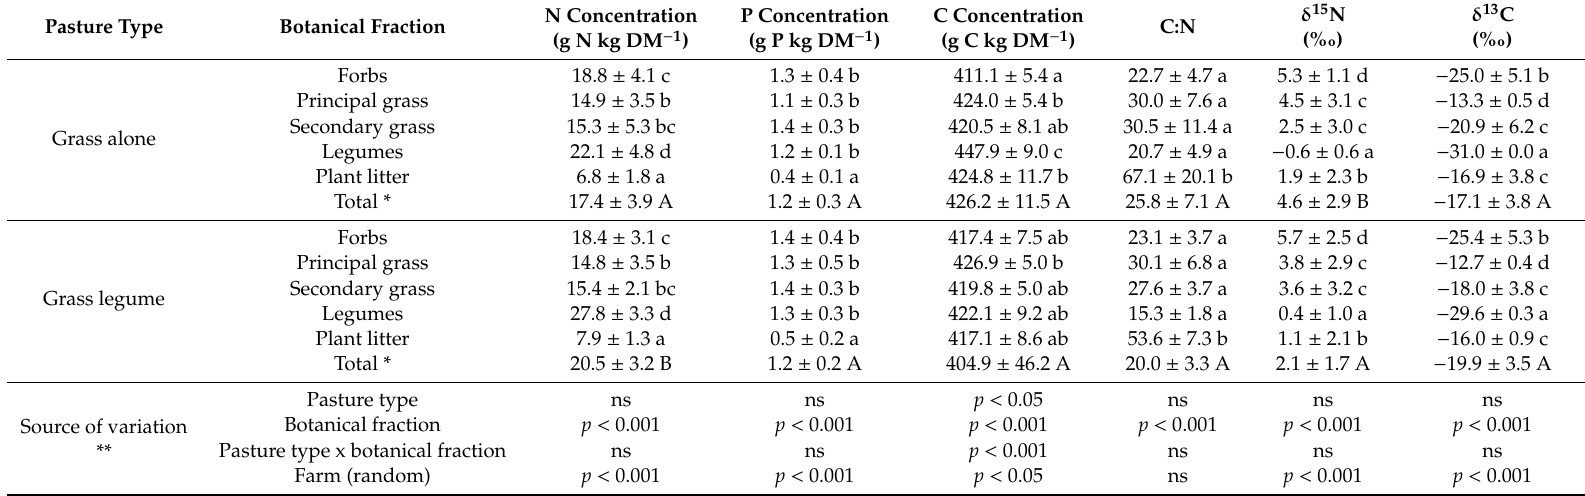
Table 2. Nutrient concentrations (N, P, C) and isotopic signatures of N and C in two di ff erent pasture types for each botanical fraction. Values are mean ± standard deviation, with n = 10 for grass alone, and n = 8 for grass-legume pastures. DM = dry matter, ns = not significant. Pasture Type